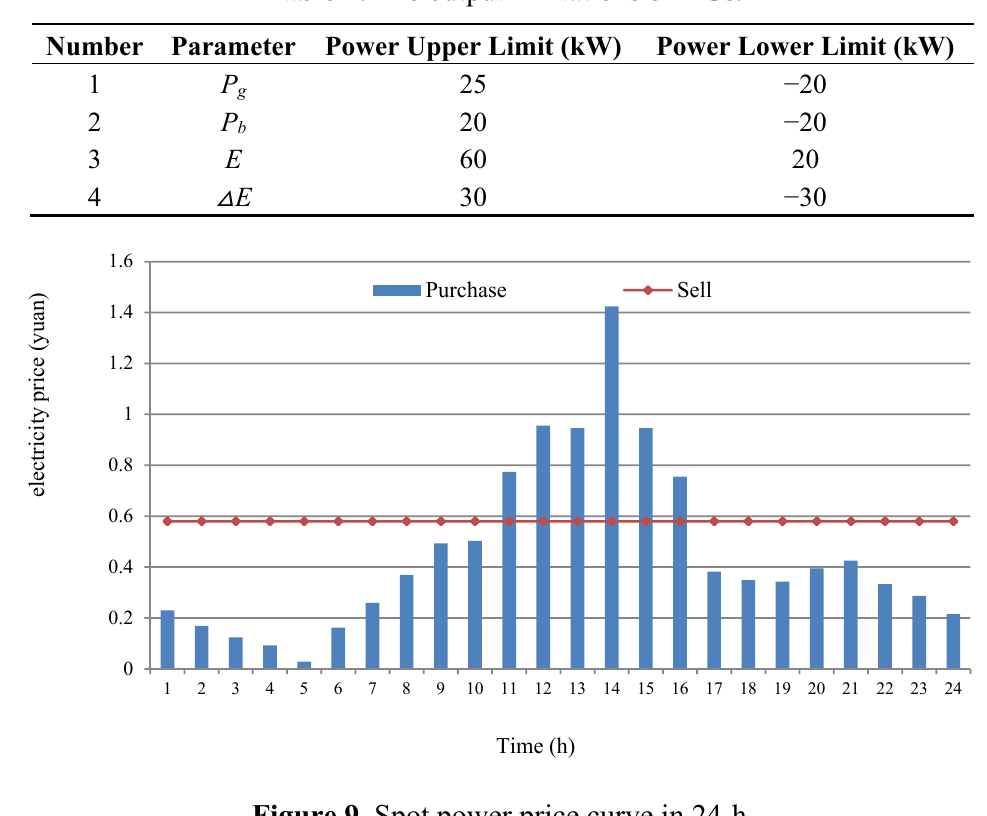
Table 4. The output limitations of DGs.